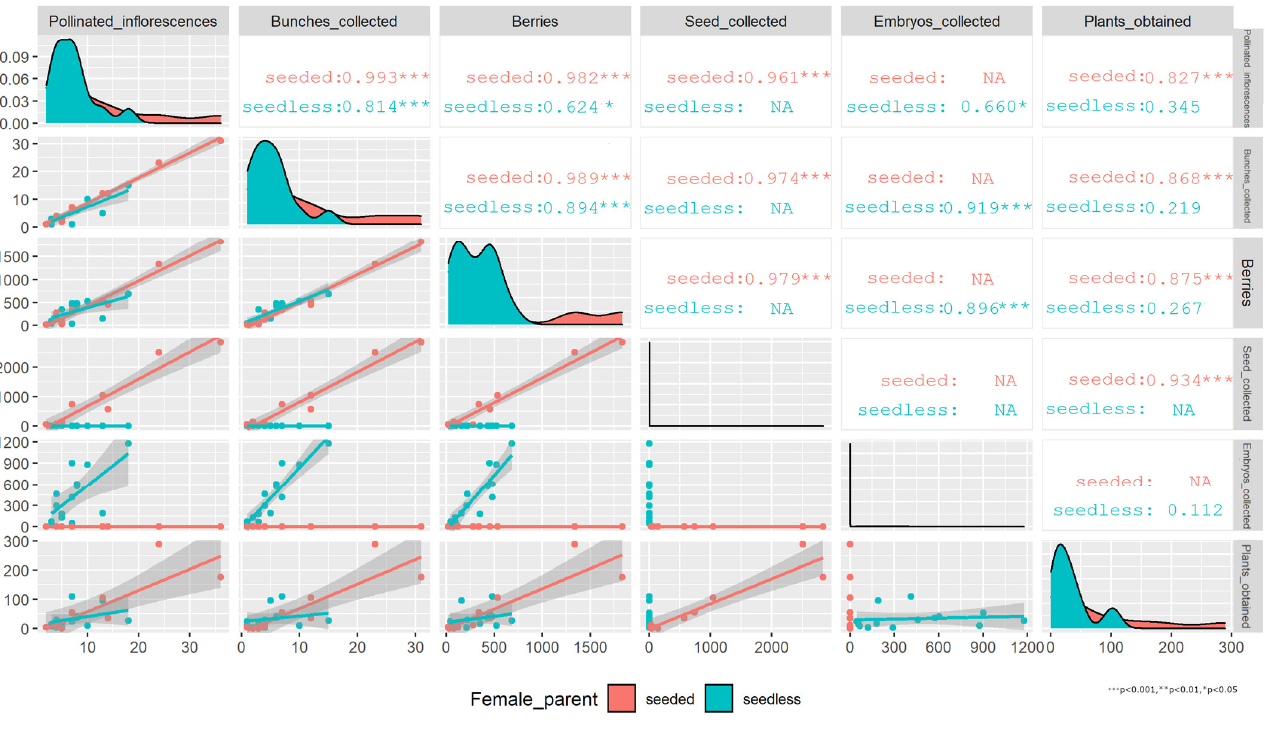
Figure 5. Pairwise correlations of crossing efficiency parameters: on the upper triangle, the pairwise Pearson correlations computed among all the parameters collected is shown; on the lower triangle the pairwise correlation between the parameters collected is shown; the diagonal line shows the histogram of each parameter in the two groups (seeded, seedless).